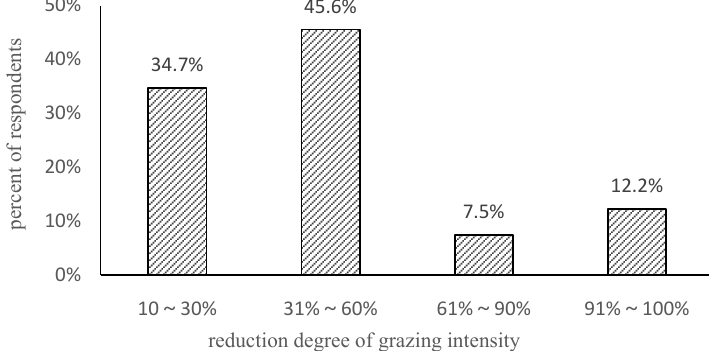
Figure 3. Distribution of herder’s reduction degree of grazing intensity.